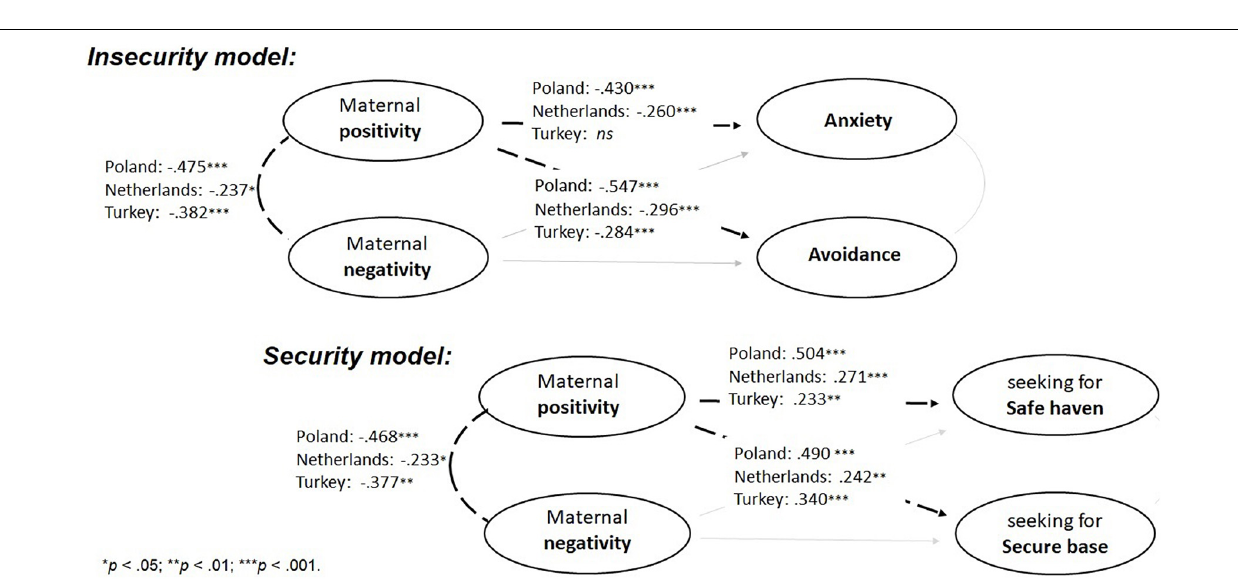
FIGURE 2 | Results of analyses testing cultural group as moderator of relations between maternal positivity, negativity and child’s attachment avoidance and anxiety (Insecurity model) and seeking the mother as a secure base and a safe haven (Security model). All relations are significant at the levels of: ∗ p < 0.05; ∗∗ p < 0.01; ∗∗∗ p <